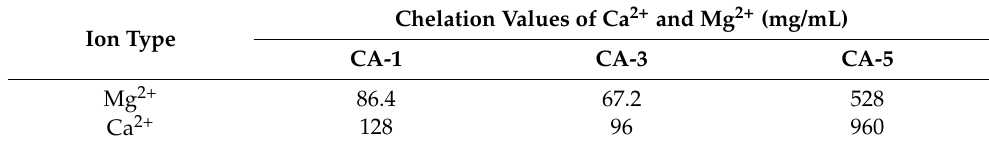
Table 4. The chelating values of three chelating